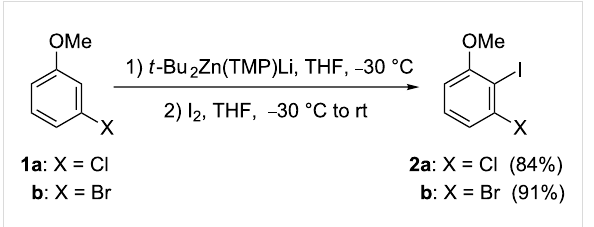
Scheme 2: Deprotonative zincation of 3-haloanisoles 1